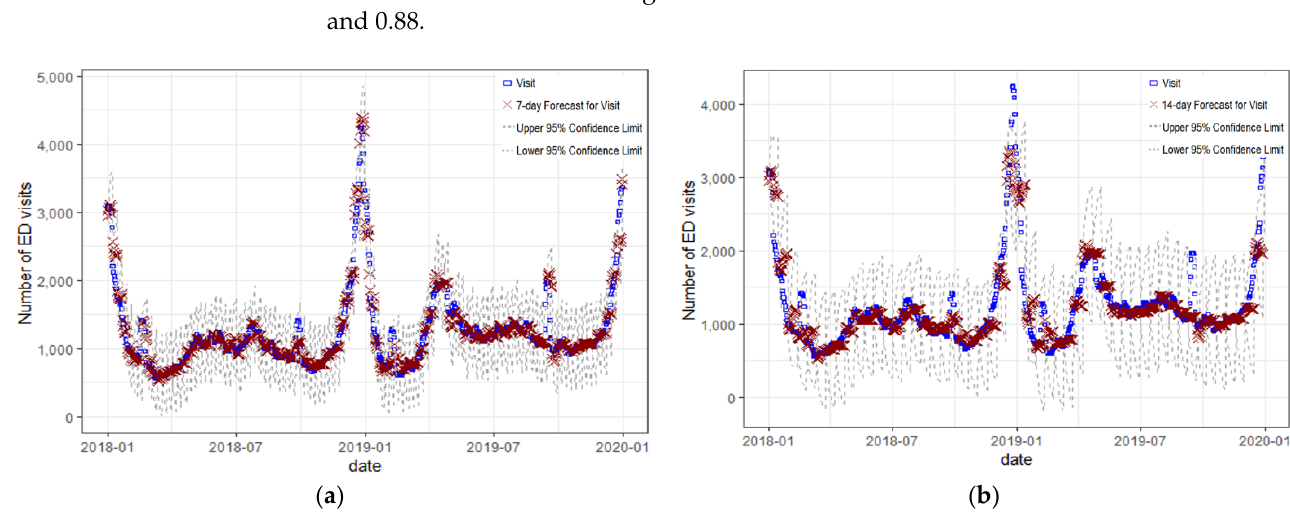
Table 3. The result of fitted ARIMA(1,1,1)(0,0,1) 7 model to forecast ED visits based on actual ED visits with fever.